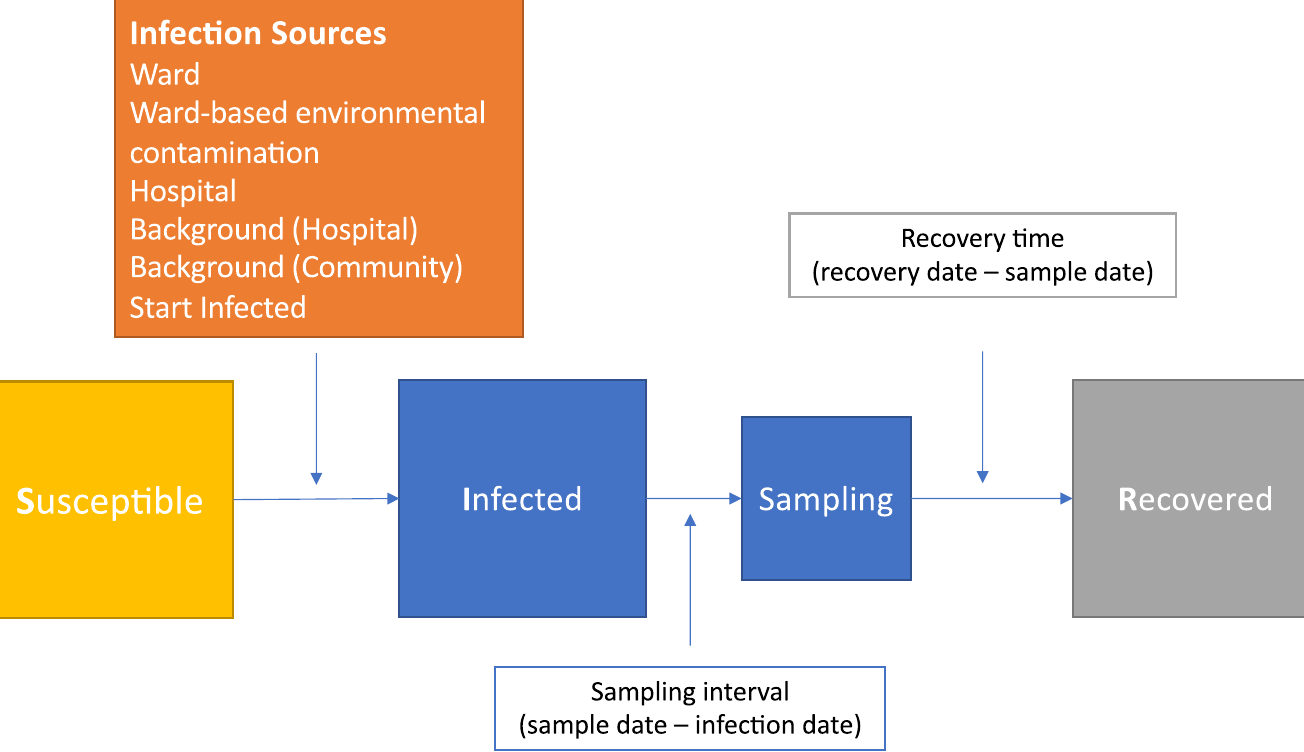
Fig 1. Transmission model states. Both boxes shaded blue represent an infectious patient.